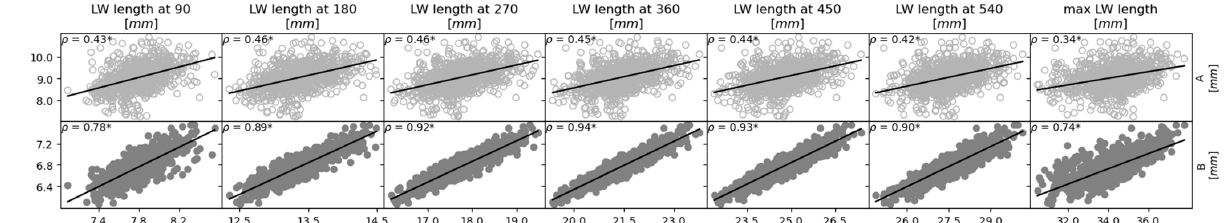
Figure 3. Correlation plots between cochlear duct lengths and cochlear size. A strong correlation ( ρ > |0.50|) between parameters is represented by scatter plots with filled circles and a weak correla- tion is shown by empty circles. Solid lines indicate the linear regression curves. ρ : Pearson correlation coefficient, * depicts significant correlation ( p -value < 0.05).